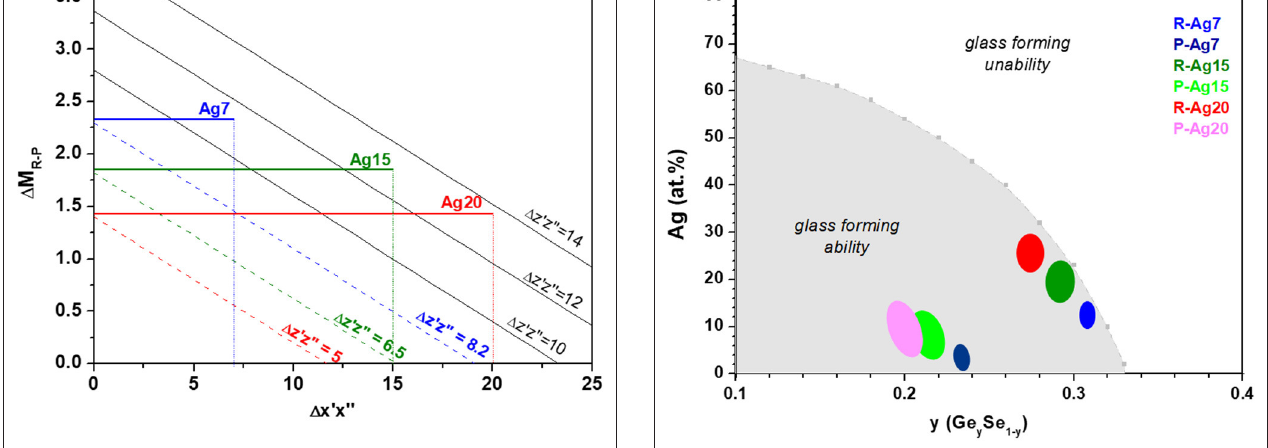
FIGURE 10 | Curve showing the limiting values of x (Ag) for each composition y (Ge) on the basis of the validity of criteria of n Se Se = 0. Color regions show compositions found for R-Agx and P-Agx